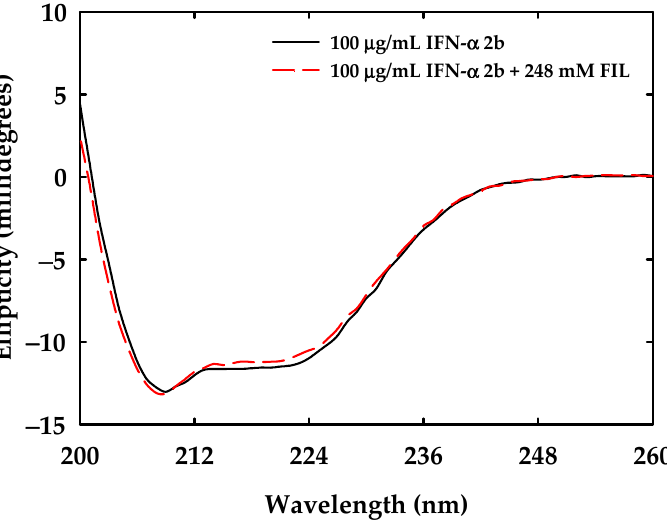
Figure 8. CD spectra of [N 1112(OH) ][C 4 F 9 SO 3 ] at 248 mM in the presence of IFN- α 2b at 100 μ g/mL in 150 mM NaH 2 PO 4 (pH = 7.4) and measured at 25 °C.